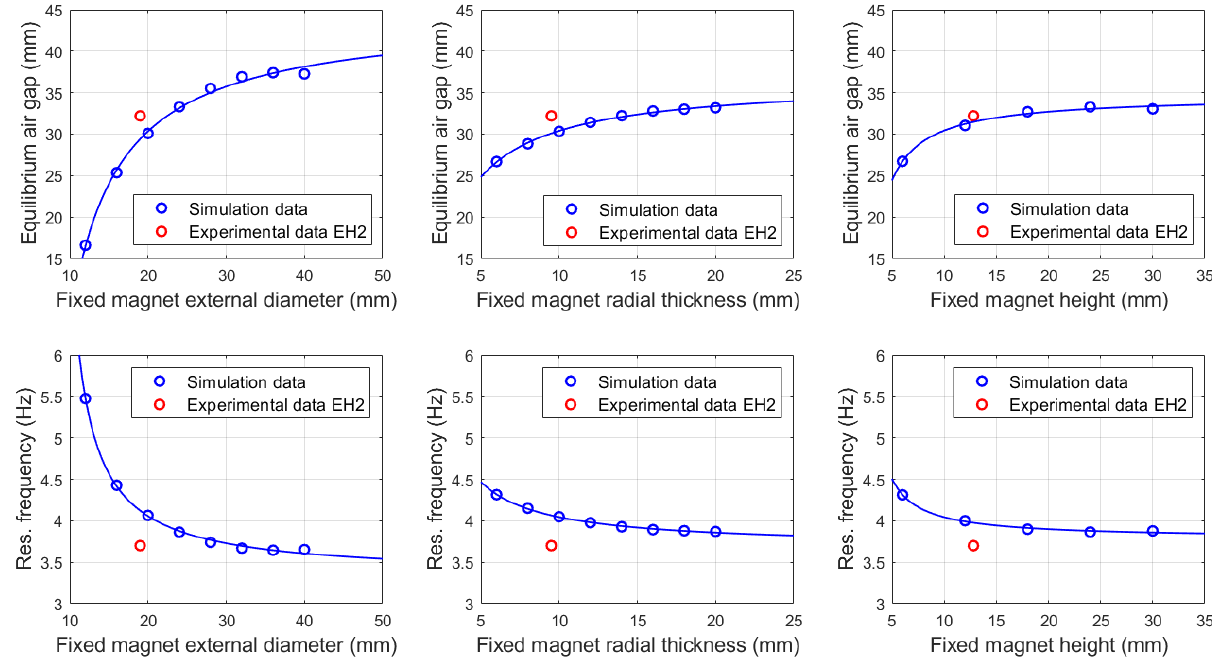
Figure 11. Fixed magnet sensitivity